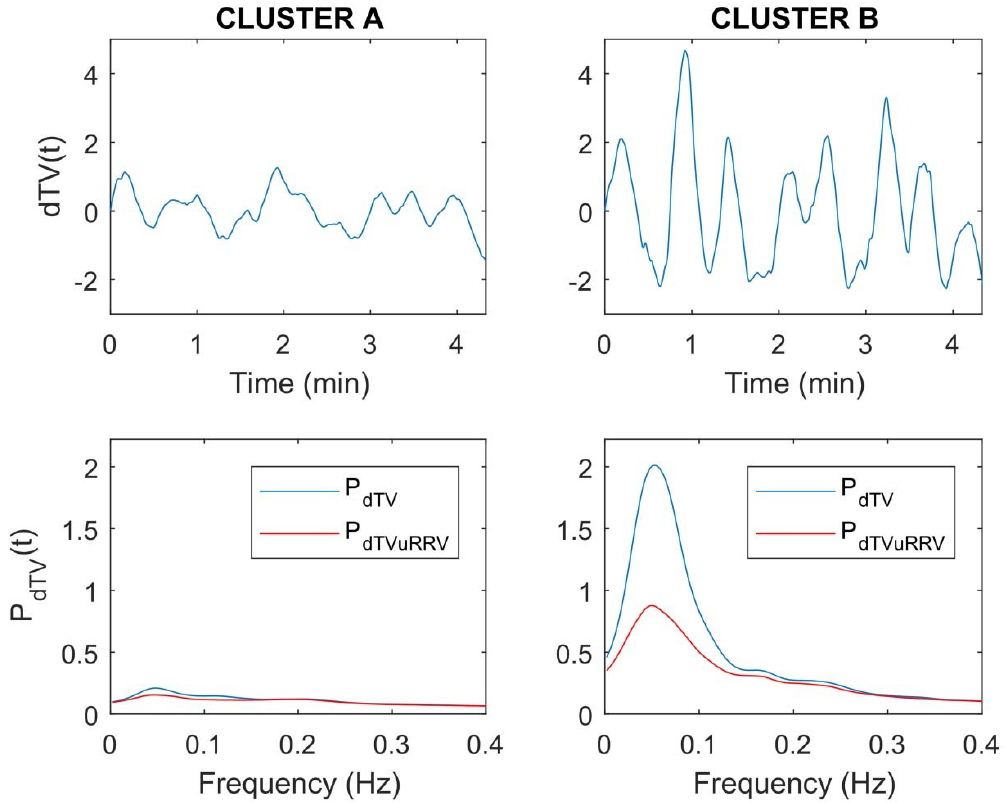
Figure 6. Examples of dTV, P dTV and P dTVuRRV at rest obtained for two subjects that are representative of each of the two clusters. A and B, described in the text.